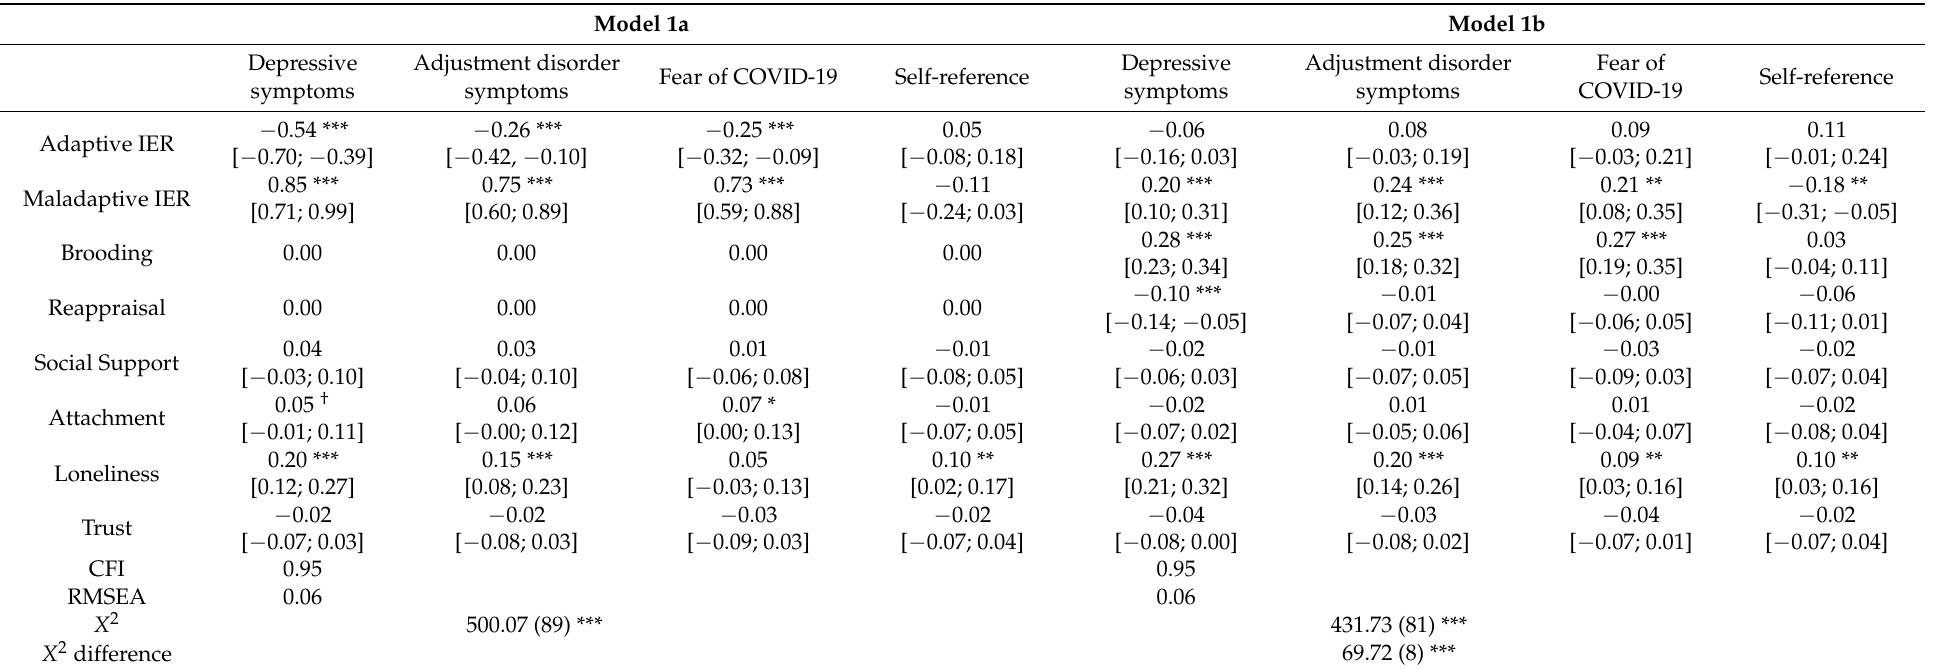
Table 2. Results of structural